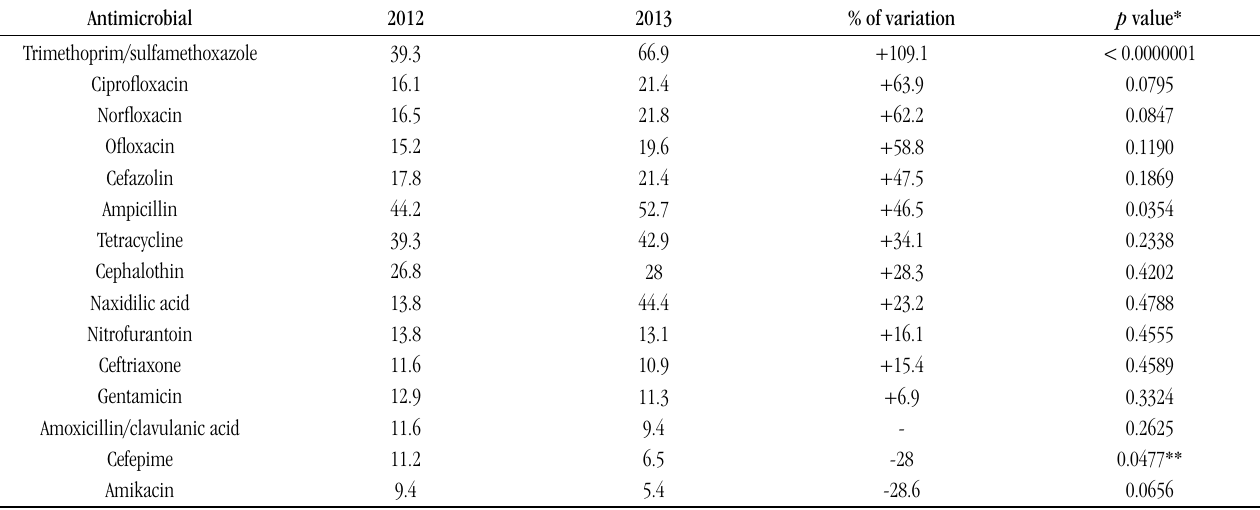
tABLE 3 – Variation in the antimicrobial resistance profile of Escherichia coli isolated from the urine of patients seen at CIS-COMCAM between 2012 and 2013